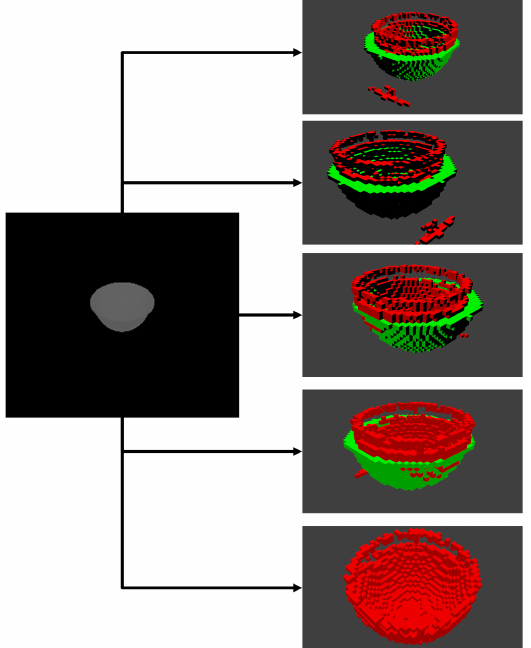
Figure 12. An example of visual comparison ground truth and prediction on the validation set of Bowl shape. Green color denotes ground truth, and red color shows